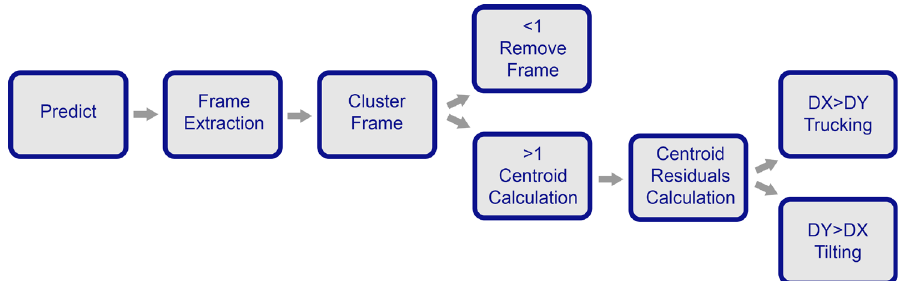
Figure 2. Workflow of the second step of the proposed match-moving method: the tilting and trucking camera motions identification suitable for photogrammetry.